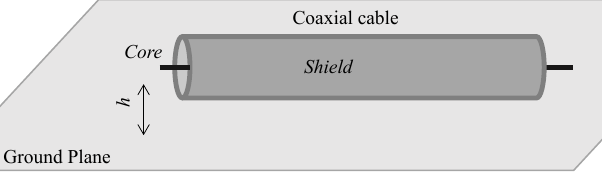
FIGURE 1 . Coaxial cable configuration